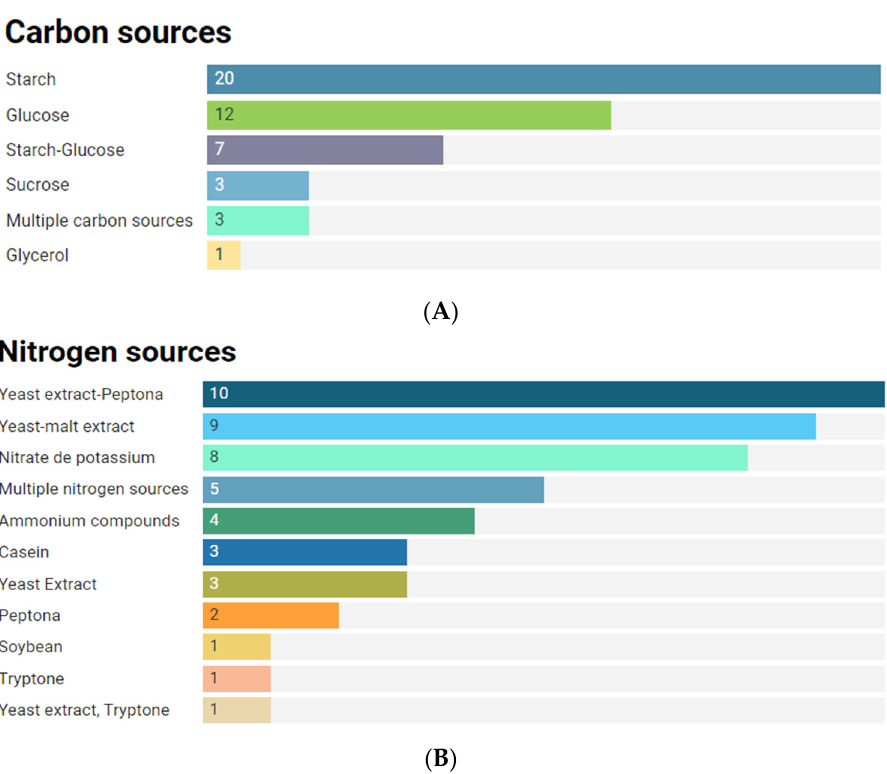
Figure 6. ( A ). Most used carbon sources to maximize the anti-infective compound. ( B ). Most used nitrogen sources to maximize the anti-infective compounds. Only 48 of 177 papers reported culture conditions.